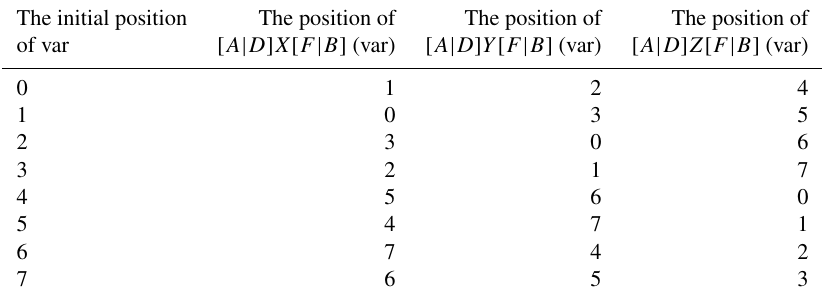
Table 2. The jumping rules of an operator acting on an Array . The initial position The position of The position of The position of of var